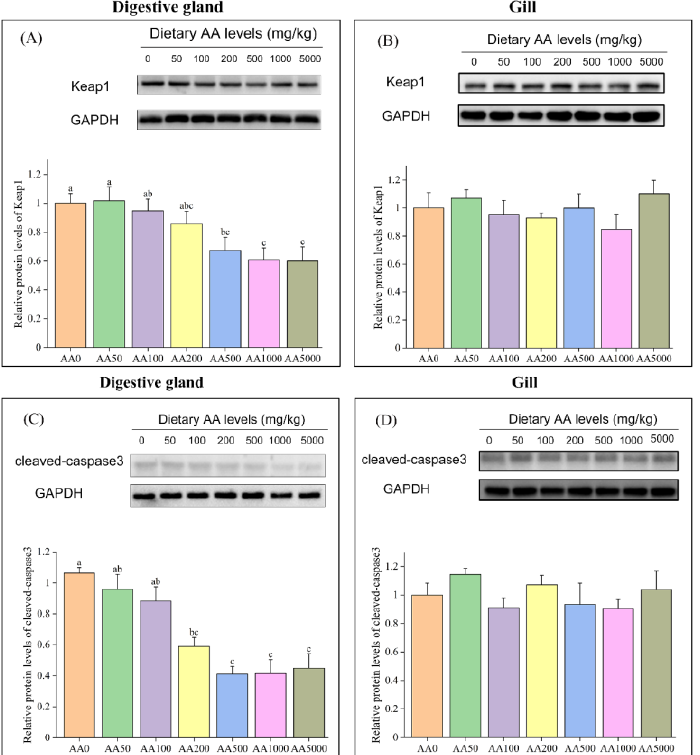
Figure 6. Protein expressions of Keap1 and cleaved-caspase3 in the digestive gland and gill of abalone ( Haliotis discus hannai ) after a 100-day feeding trial. ( A ) Protein expressions of Keap1 in the digestive gland of abalone. ( B ) Protein expressions of Keap1 in abalone gill. ( C ) Protein expressions of cleaved-caspase3 in the digestive gland of abalone. ( D ) Protein expressions of cleaved-caspase3 in abalone gill. All data expressed as mean ± SE ( n = 3). The different lowercase letters indicate significant differences ( p < 0.05).